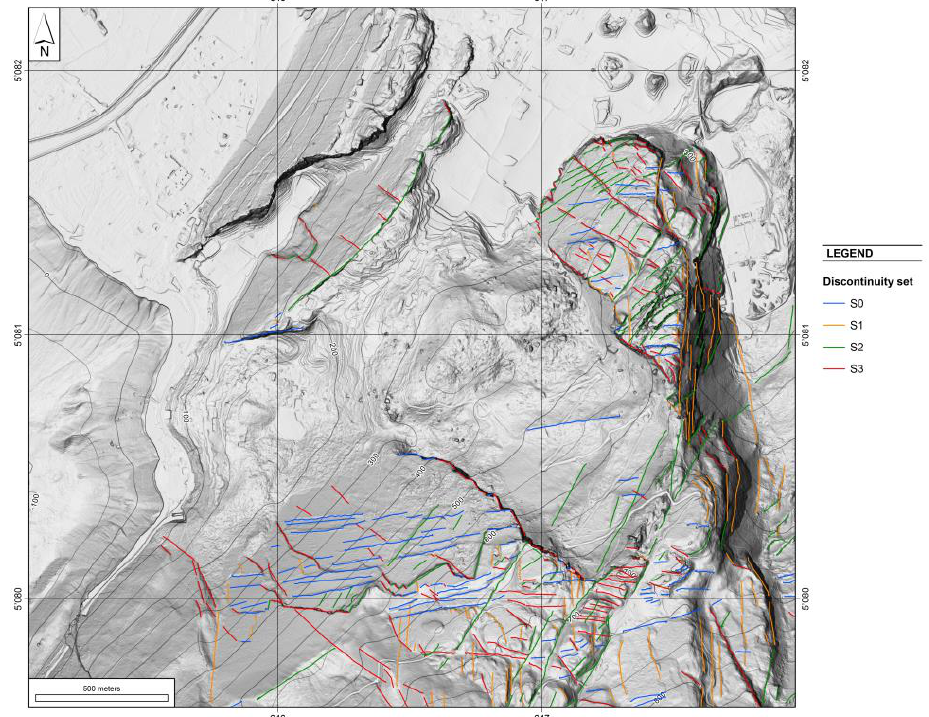
Figure 6. Structural lineaments identified in the study area. The measured discontinuities are grouped into four sets, identified by different colors. Colors of sets correspond to those of Figure 7. The bedding (S 0 ) has an average orientation of 313 ◦ /27 ◦ (dip direction/dip angle), with dip angles varying from 20 ◦ –25 ◦ in the upper part to 25 ◦ –28 ◦ in the central